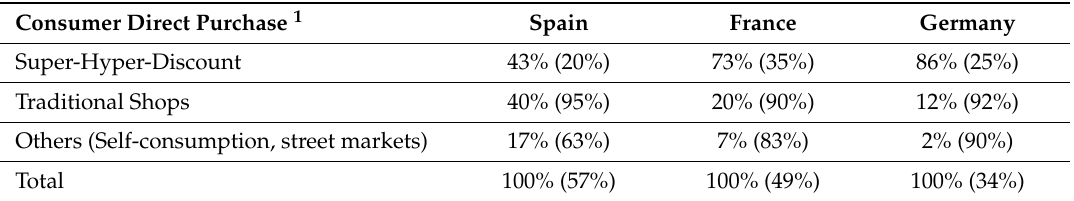
Table 1. Fruit and vegetable (F&V) purchase percentage of end consumer and percentage of supply from wholesalers or intermediaries